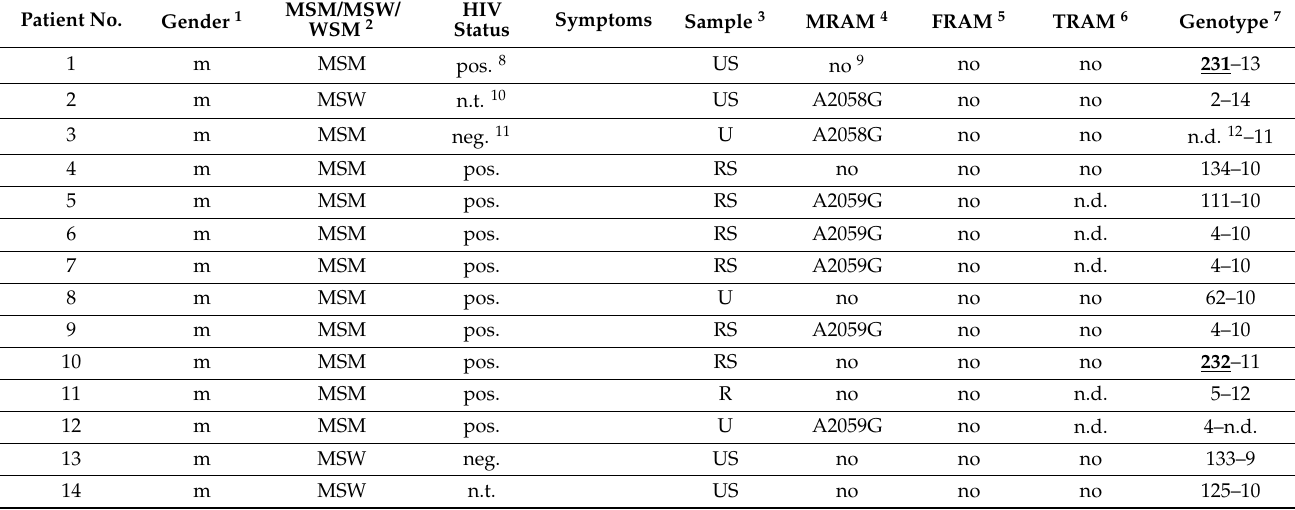
Table 1. Characteristics of patients and M. genitalium